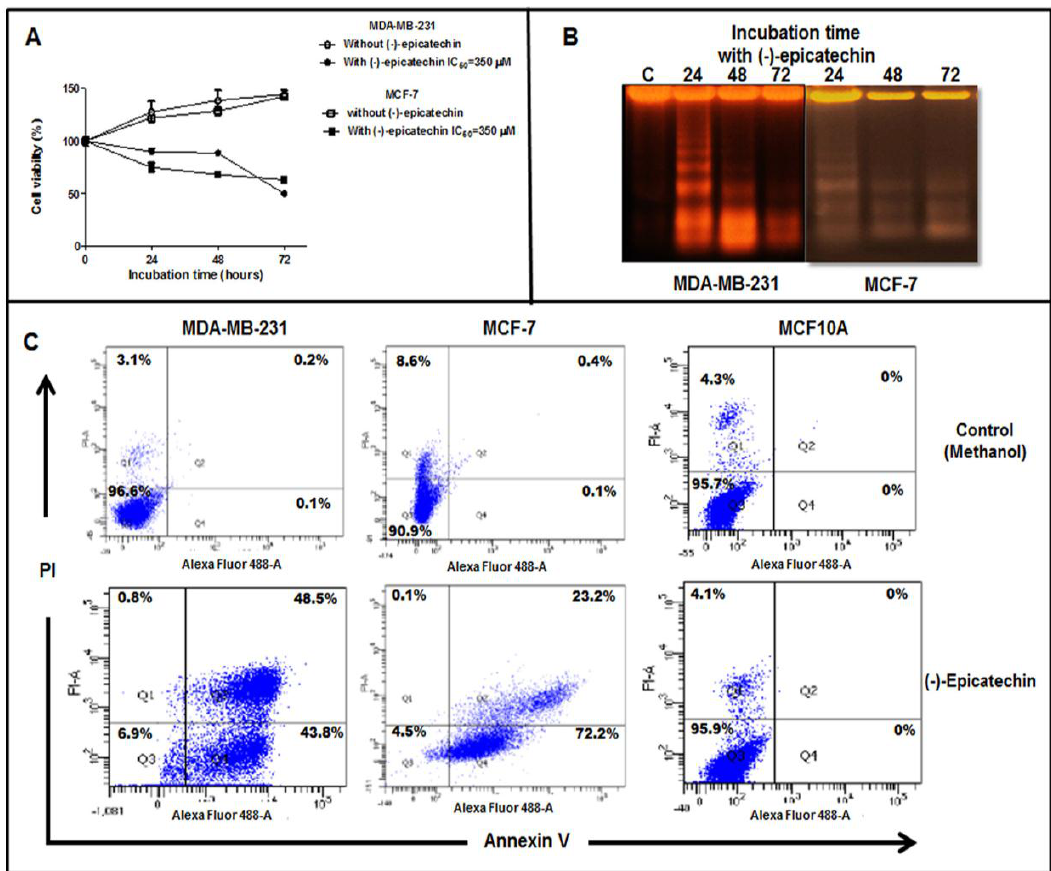
Figure 3. ( − )-Epicatechin decreases cell proliferation and induces DNA fragmentation and apoptosis. MDA-MB-231 and MCF-7 cells were grown in the indicated conditions, and the cell viability and DNA fragmentation were assessed at the given time periods. ( A ) Decreasing cell viability in the presence of ( − )-epicatechin demonstrated its e ff ects on cell proliferation. ( B ) DNA fragmentation of MDA-MB-231 and MCF-7 cells at the indicated times in the presence of ( − )-epicatechin. ( C ) MDA-MB-231, MCF-7, and MCF10A were grown in the absence or presence of ( − )-epicatechin and stained with Annexin V / PI (propidium iodide) and subjected to flow cytometric analysis. The four quadrants represent living cells (Annexin V–PI–), early apoptotic (Annexin V + PI–), late apoptotic (Annexin + PI + ), or necrotic (Annexin V–PI + ) stages. The percentages of cells obtained are indicated in each quadrant, and the results are representative of three similar experiments.